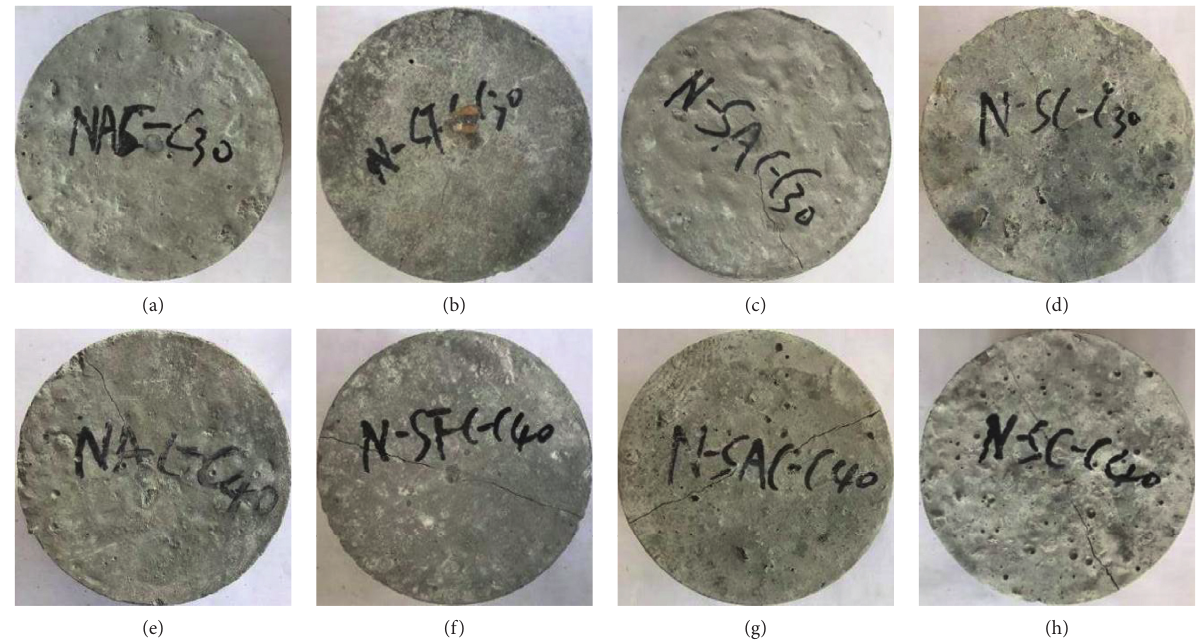
Figure 9: Initial cracking state of concrete. (a) NAC-C30. (b) N-SFC-C30. (c) N-SAC-C30. (d) N-SC-C30. (e) NAC-C40. (f) N-SFC-C40. (g) N-SAC-C40. (h)